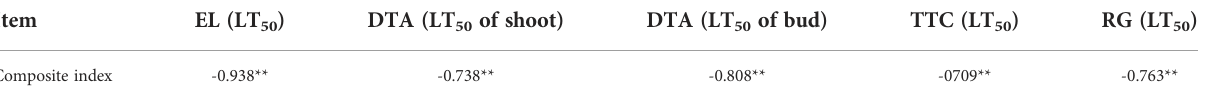
TABLE 8 Correlation analysis between the cold composite index and LT 50 values.